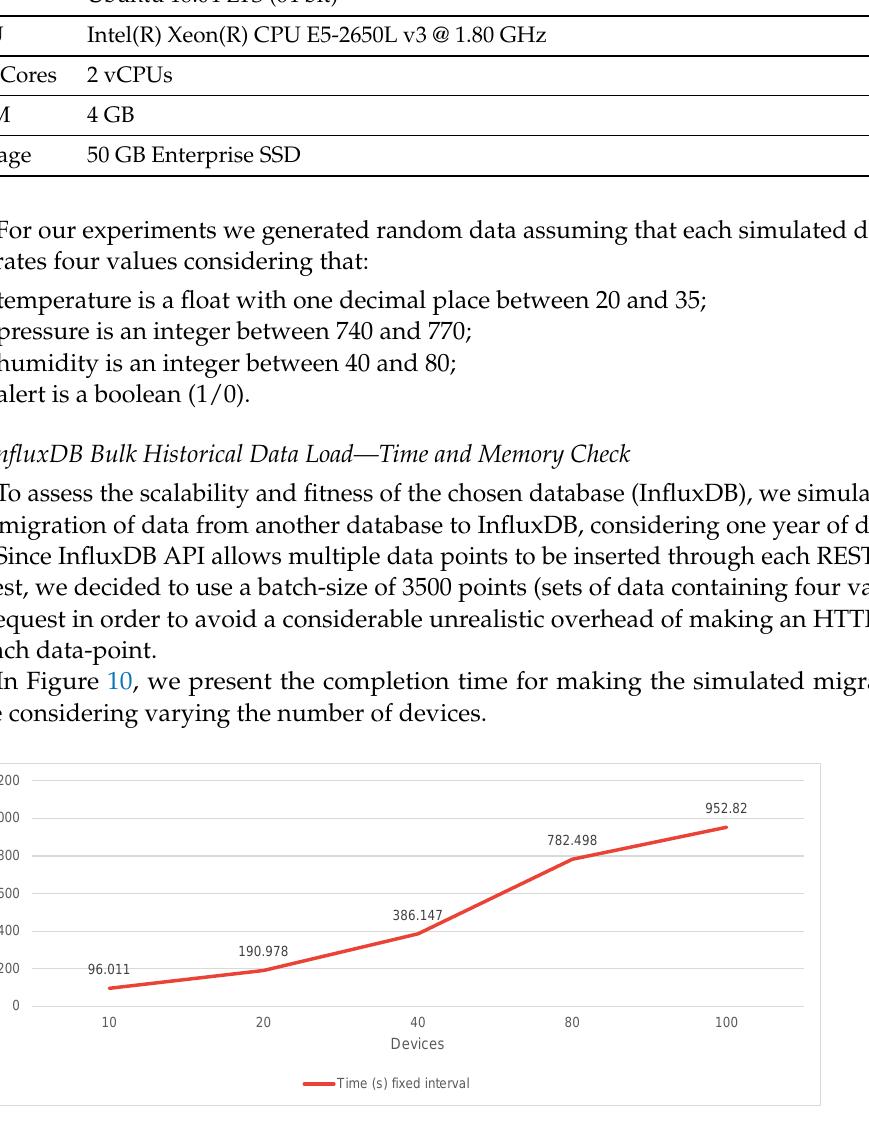
Figure 10. Elapsed time loading data for every 15 min for 1 year. Batch size